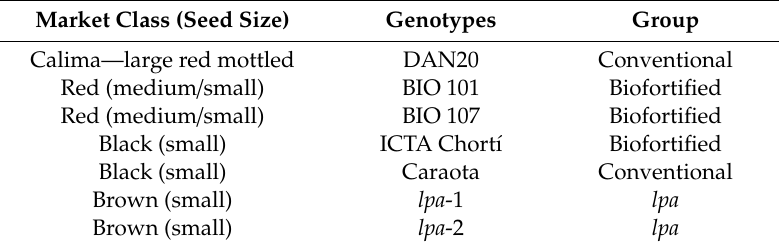
Table 1. Description of included genotypes of